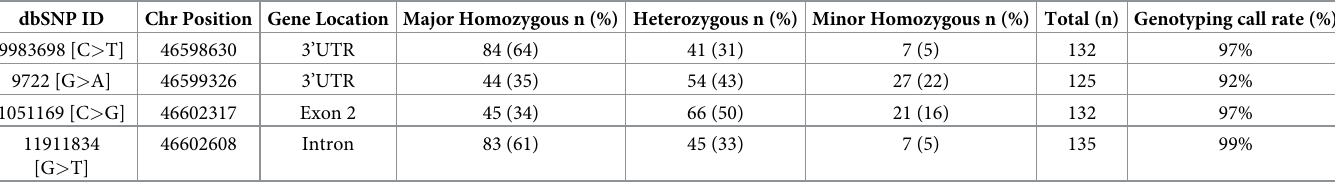
Table 3. Genotype frequencies.